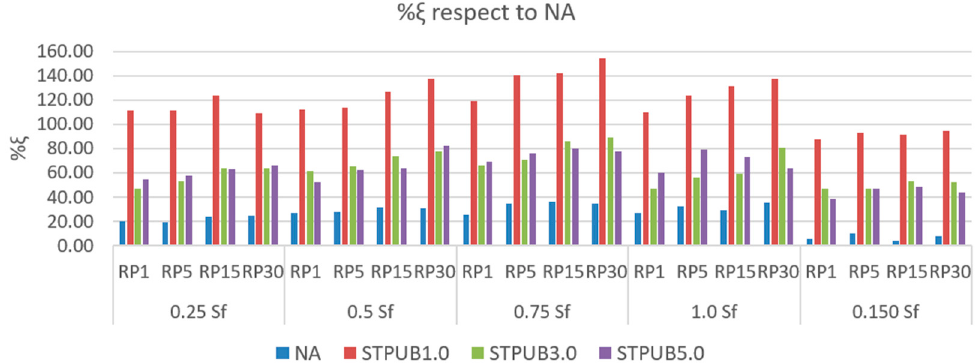
Figure 17. % ξ respect to NA with di ff erent RPs and damage levels.